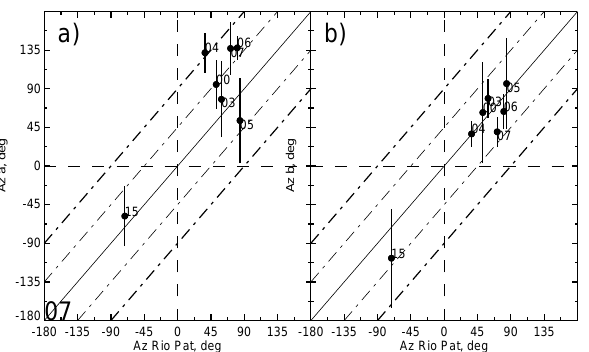
Fig. 8. The azimuth of the patch’s (a) longest and (b) shortest di- mension versus azimuth of the patch drift from 14 February 2001 for C min =0.5, 1H min =30nT, 1t min =10min. The digits by each point indicate the patch number, Figs. 1,